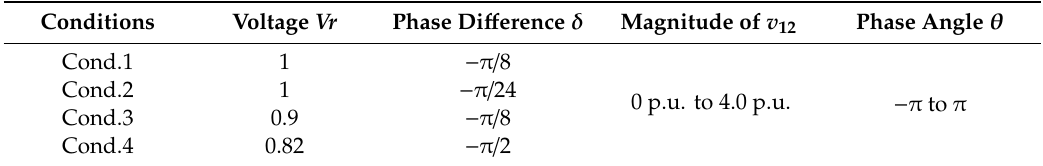
Table 1. Typical system operation conditions in case study.